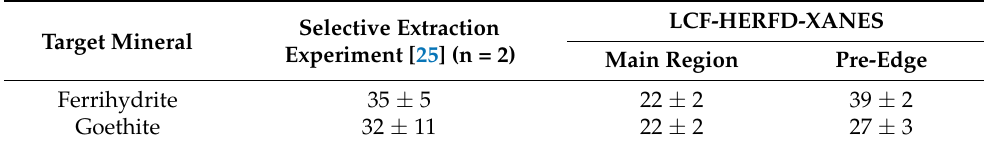
Table 1. Ferrihydrite and goethite fractions in MT21-S2 (in wt.%). LCF-HERFD-XANES Selective Extraction Target Mineral Experiment [25] (n = 2) Main Region Pre-Edge Ferrihydrite 35 ± 5 22 ± 2 39 ± 2 Goethite 32 ± 11 22 ± 2 27 ±